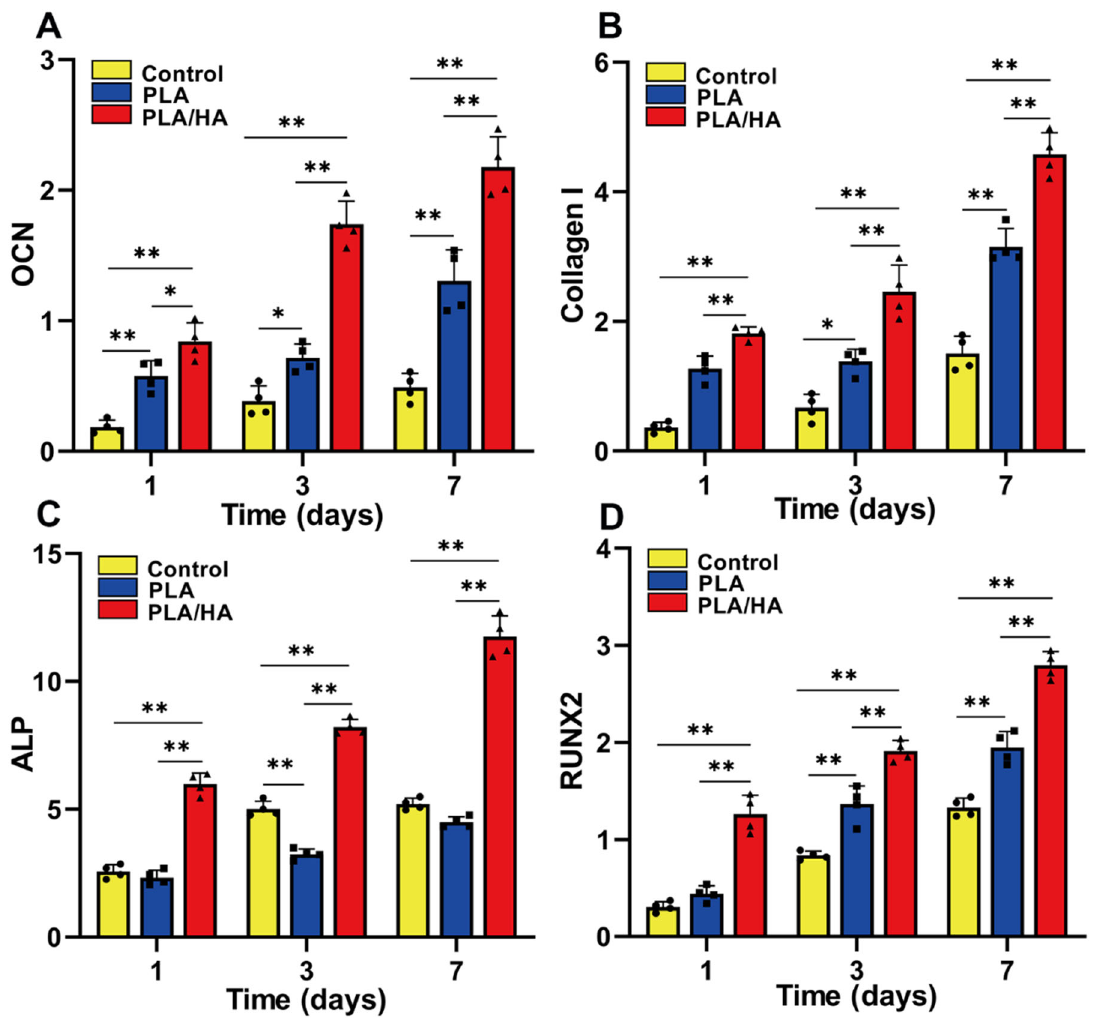
Fig. 5 Relative mRNA expression levels of osteogenic genes in the different groups (Control, PLA and PLA/HA groups) at each time point (1, 3, 7 days after experiment). A OCN . B COL I . C ALP . D RUNX2 . * p < 0.05; ** p <